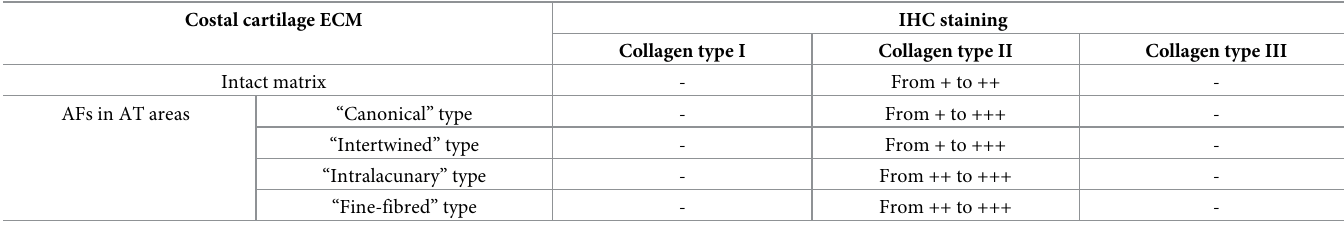
Table 1. Immunohistochemical analysis of normal, PE and PC costal cartilages in children. Costal cartilage